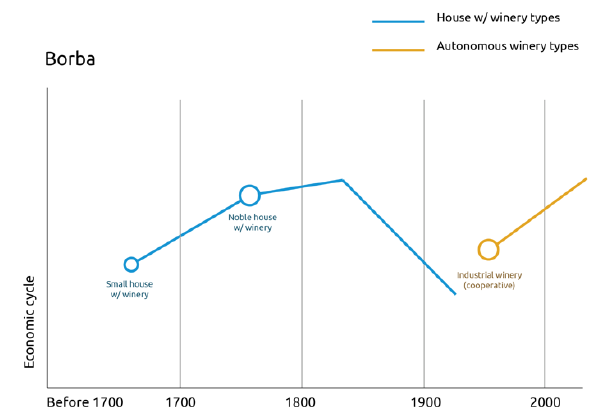
Figure 11. Chronological display of Borba’s winery types, by typological line of evolution.